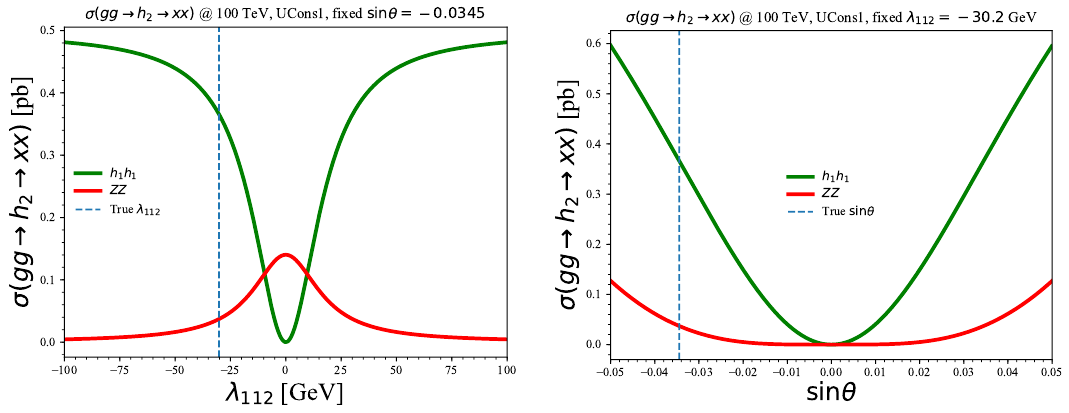
Figure 4 . The cross sections for pp → h 2 → h 1 h 1 and pp → h 2 → ZZ for the “UCons1” benchmark point of ref. [54], as functions of either λ to the true values,